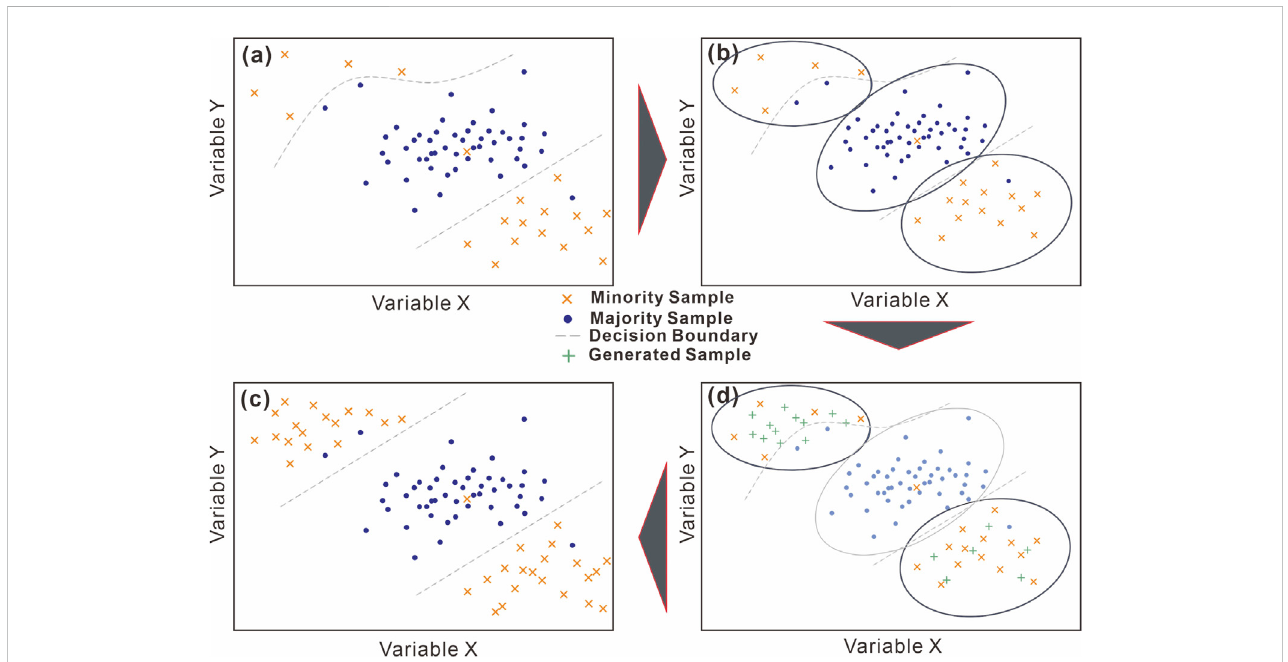
FIGURE 4 The K-means SMOTE oversamples safe areas and combats within-class imbalances (Douzas et al., 2018). (A) Input data. (B) Find k =3 clusters and compute the imbalance ratio (IR). (C) Use SMOTE to oversample clusters with IR > 1, generating more samples in sparse clusters. (D) . Oversampled data rectify the decision